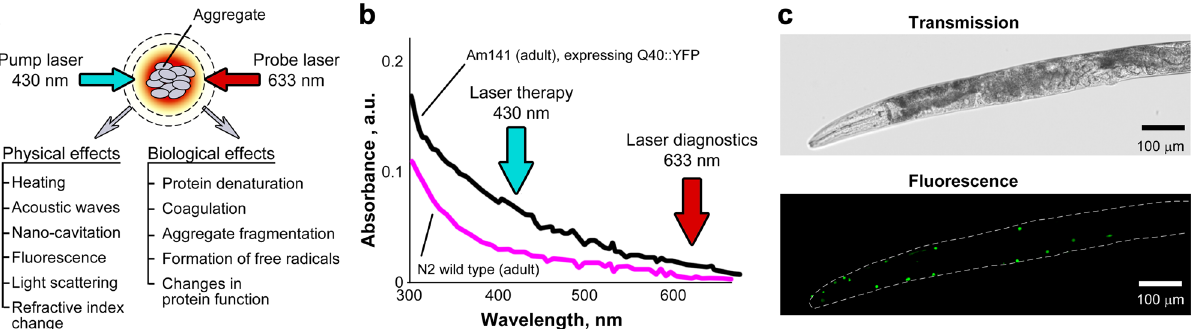
Figure 1. Laser-based theranostics of protein aggregates. ( a ) Principle of theranostics based on controllable PT and accompanying phenomena, both physical (e.g., acoustic and nanobubble) and biological (e.g., denaturation). ( b ) Laser excitation at two wavelengths for therapy (430 nm) and monitoring of resultant effects (633 nm). ( c ) Bright-field (transmission, top panel) and fluorescence microscopy (bottom) of a day-4 adult AM141 nematode showing Q40::YFP aggregates (green